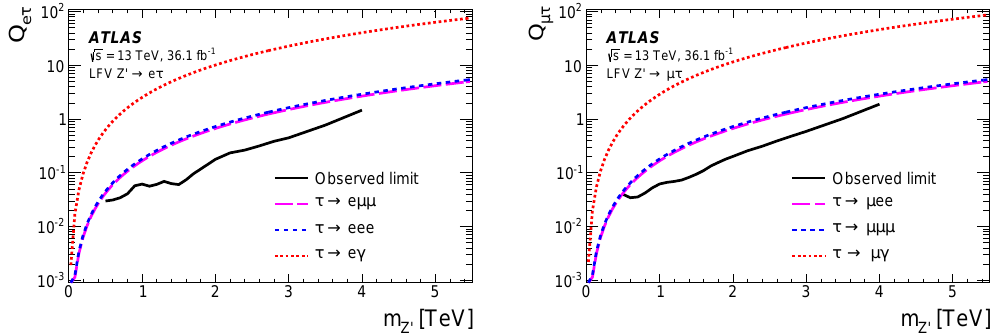
Figure 7: The observed upper limits on the lepton flavour violating e τ and µτ cou- plings as a function of a potential Z (cid:48) boson [ 20 ] . The observed limit for 13 TeV collisions now exceeds that of measurement of LFV via direct τ